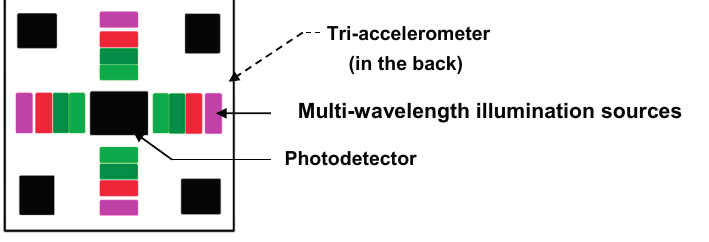
Figure 2. Schematic diagram of Opto-Electronic Patch Sensor (OEPS) with